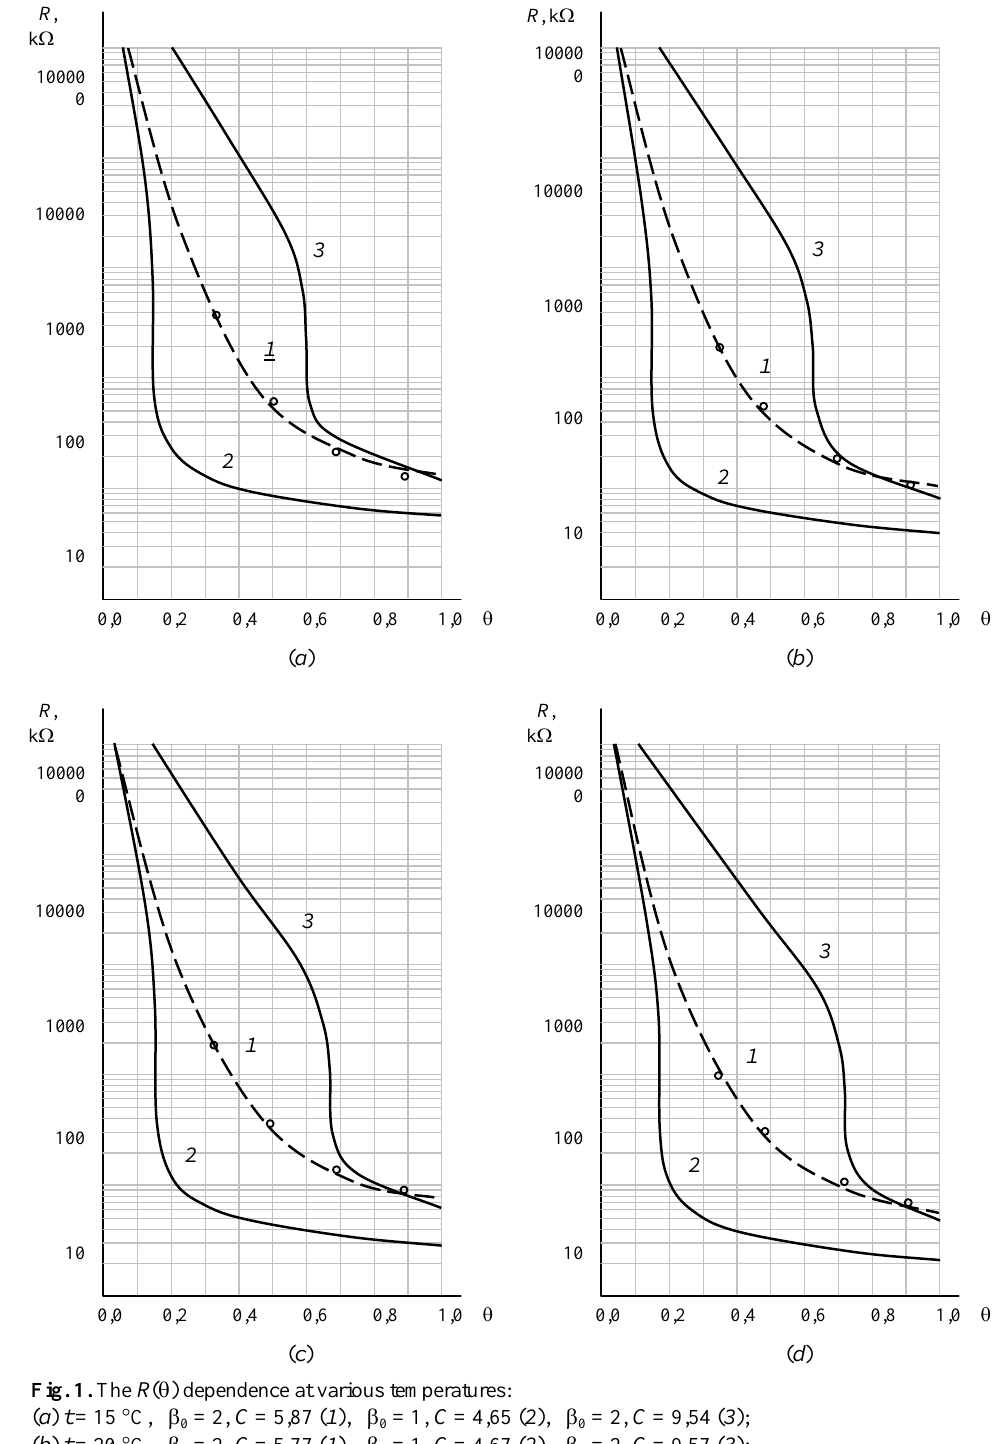
Fig. 1. The R ( θ ) dependence at various temperatures: ( a ) t = 15 ° C, β 0 = 2, C = 5,87 ( 1 ), β 0 = 1, C = 4,65 ( 2 ), β 0 = 2, C = 9,54 ( 3 ); ( b ) t = 20 ° C, β 0 = 2, C = 5,77 ( 1 ), β 0 = 1, C = 4,67 ( 2 ), β 0 = 2, C = 9,57 ( 3 ); ( c ) t = 30 ° C, β 0 = 2, C = 5,58 ( 1 ), β 0 = 1, C = 4,69 ( 2 ), β 0 = 2, C = 9,67 ( 3 ); ( d ) t = 40 ° C, β 0 = 2, C = 5,40 ( 1 ), β 0 = 1, C = 4,70 ( 2 ), β 0 = 2, C = 9,77 ( 3